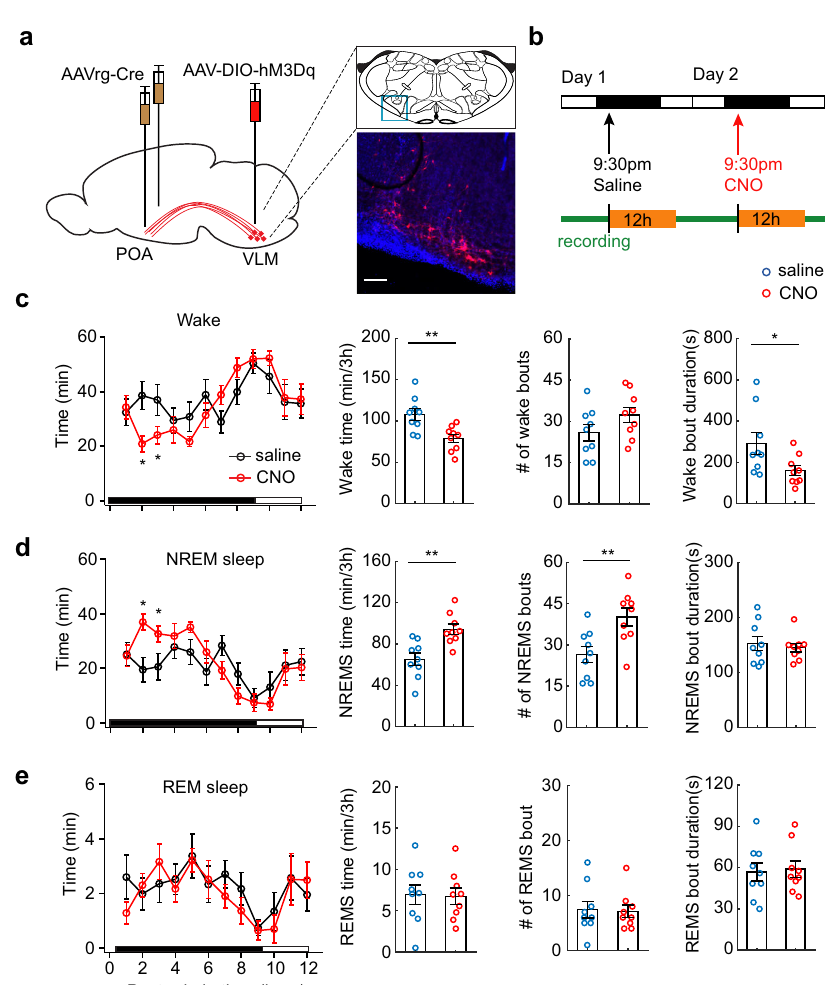
Fig.6|ChemogeneticactivationofPOA-projectingmedullaneuronspromotes NREM sleep. a Schematic of chemogenetic activation. AAVrg-Cre was bilaterally injected in the POA, AAV-DIO-hM3D(Gq)-mCherry was unilaterally injected in the VLM of wild-type mice. Right, Fluorescence image of a coronal section in the VLM (blue box above) showing expression of excitatory DREADDs ( n =8 mice). Mouse brain fi gureadapted from Allenmouse brain atlas. Red,mCherry, Blue,DAPI.Scale bar 100 μ m. b Schematic of drug administration and sleep recording. c Wake time per hour over a 12-h time window following CNO (1mg/kg, i.p. red circles) and saline (black circles) treatments. Right, quantitation of the total wake time